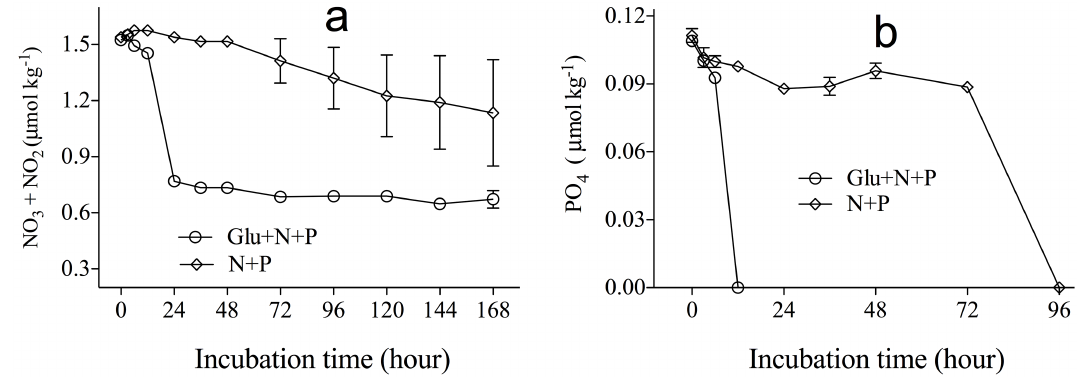
Figure 2. Variations of dissolved inorganic nitrogen and phosphate concentrations during the incubation time course of the nutrient-enriched treatments. (Non-inorganic-nutrient-enrichment treatments are not shown since they were below the detection limits.) Value “0” in (b) means below the detection limit. Error bars indicate standard errors.